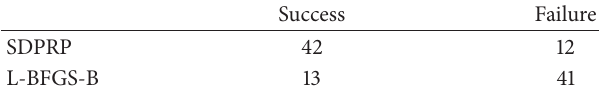
Table 4: Statical data of SDPRP and